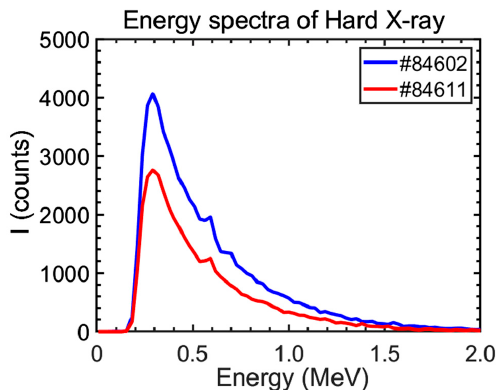
Figure 10. Energy spectra of runaway electron at I p platform before (#84602, blue line) and after (#84611, red line) lithium granule injection.